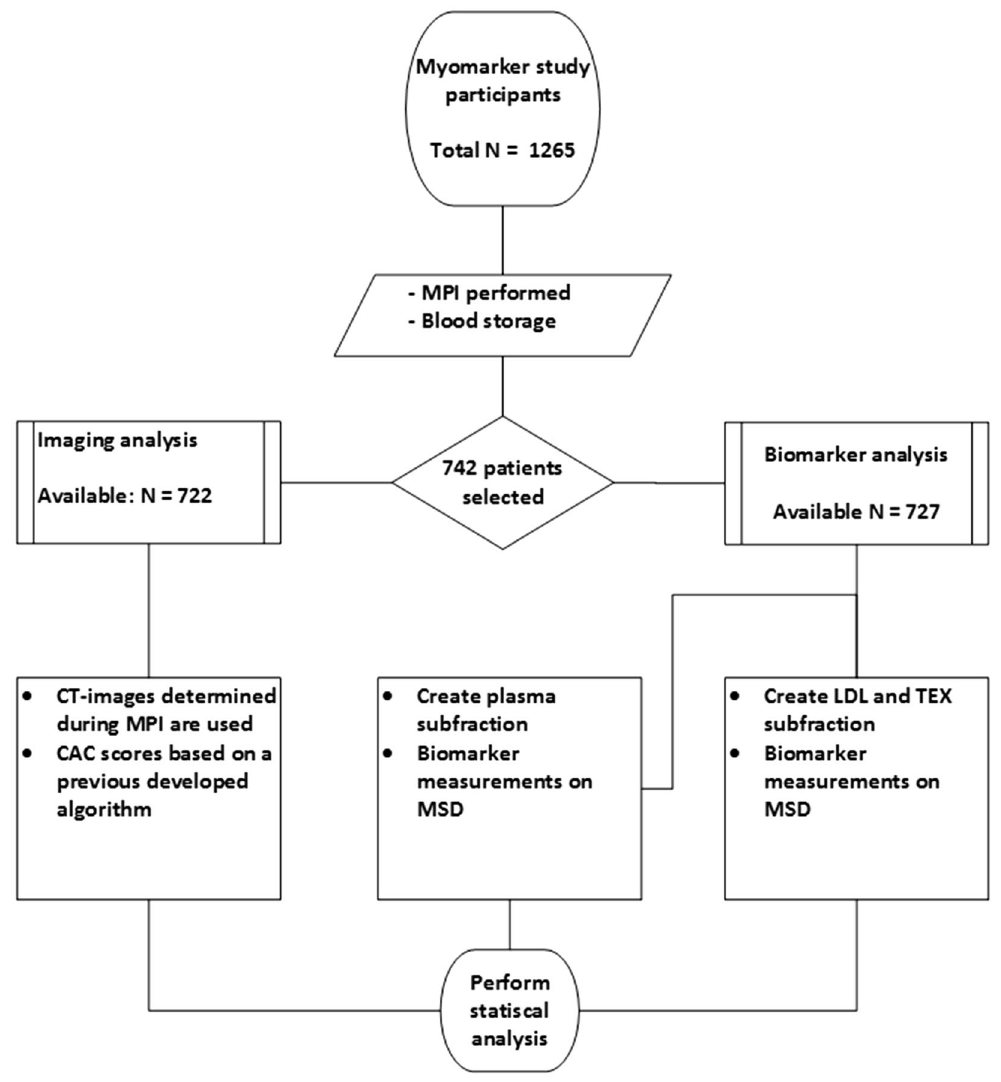
Figure 1. Study protocol. MPI myocardial perfusion imaging, CAC coronary artery calcification, MSD MesoScaleDiscovery platform. LDL and TEX refer to extracellular